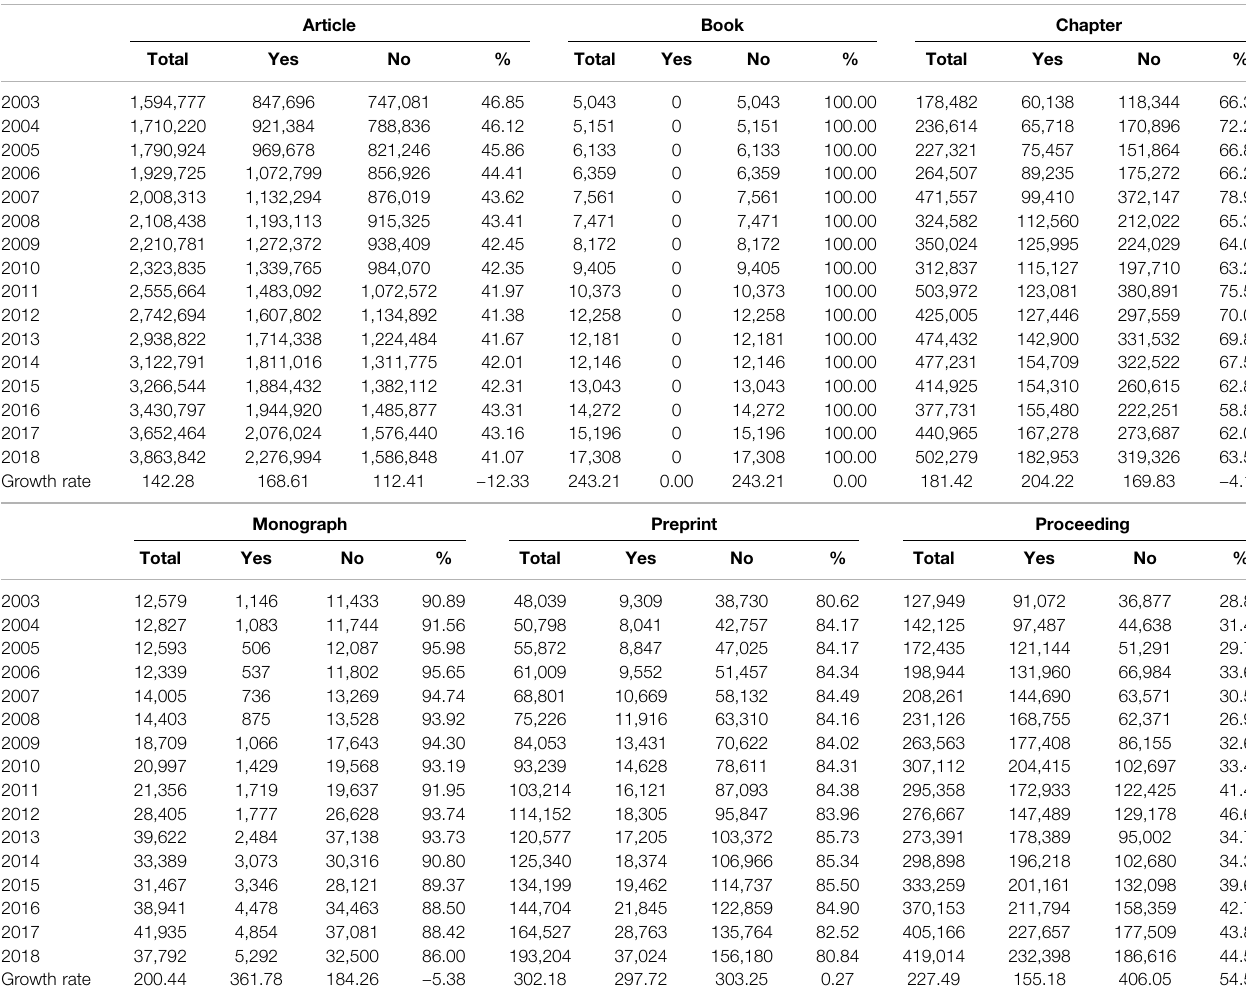
TABLE 4 | Distribution of document types where no country af fi liation data is